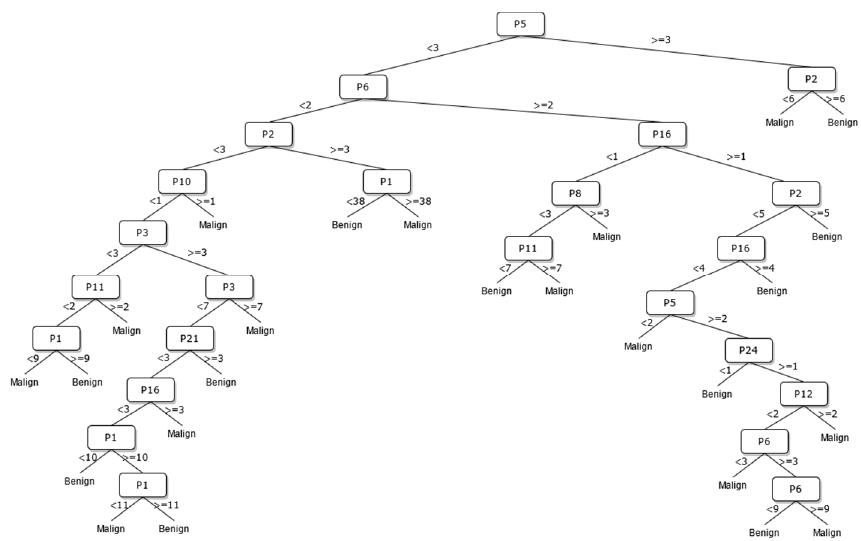
Figure 6. The DT of 13 sonographic signs.